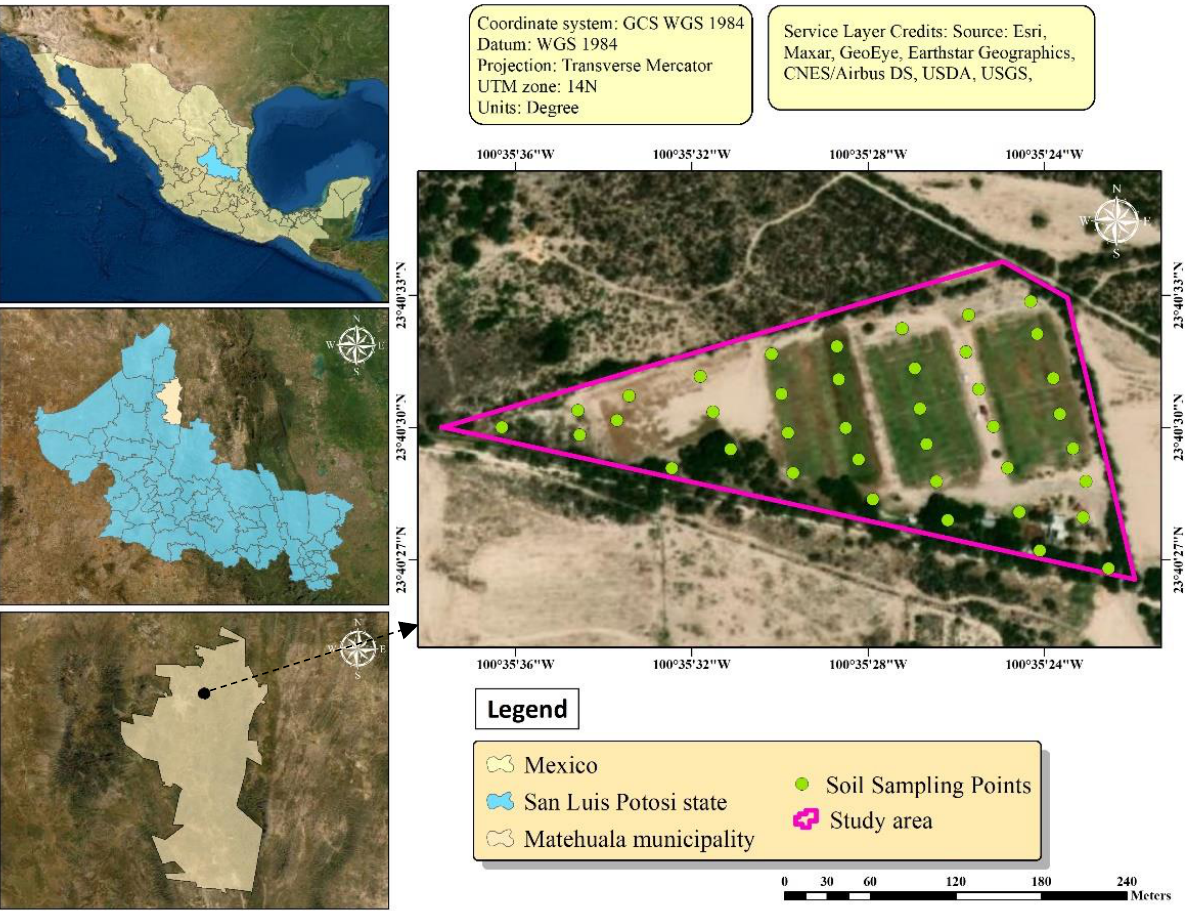
Figure 1. Locations of soil samples are shown on a map of the study area.